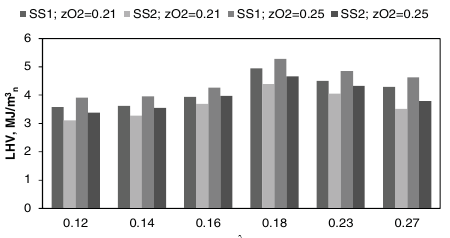
Fig. 5. In fl uence of the gasi fi cation composition on the